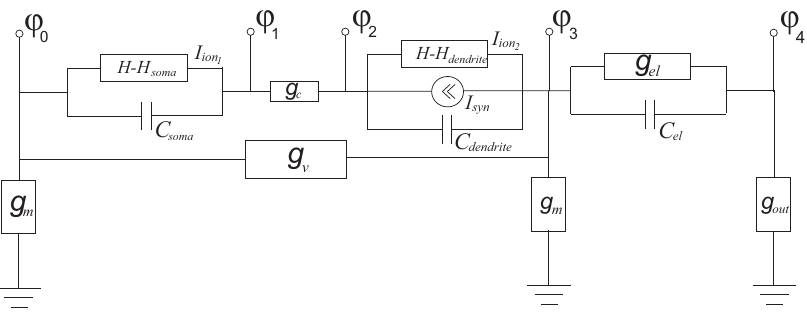
Figure 3. The equivalent electrical scheme of two-compartment